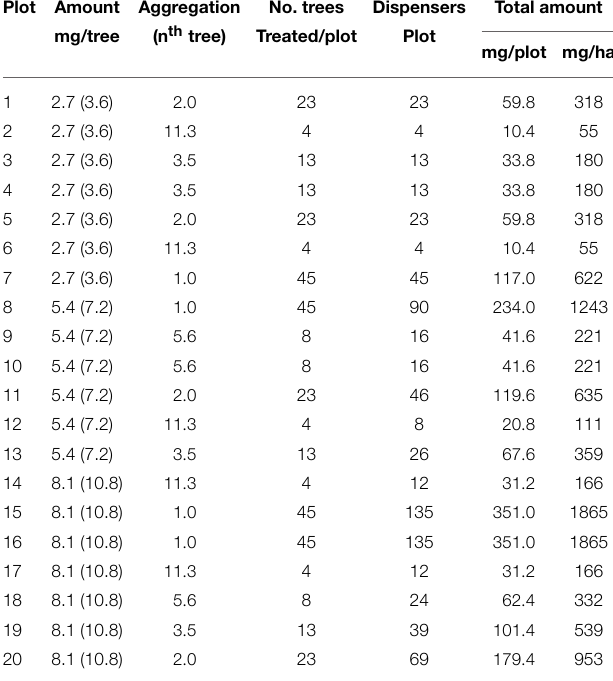
TABLE 1 | Treatment combinations and parameters of two field trials using a D–optimal design to study the effect of amount of pheromone, aggregation of release points and their interaction on trap catch disruption for Phyllocnistis citrella . Plot Amount Aggregation No. trees Dispensers